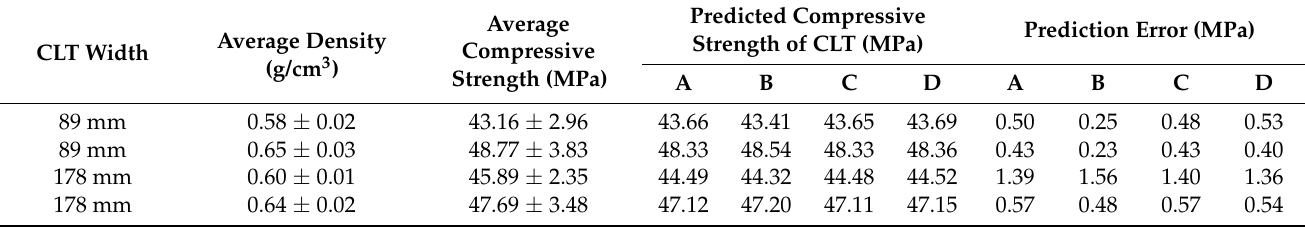
Table 8. Average compressive strength of CLT, calculated using the four